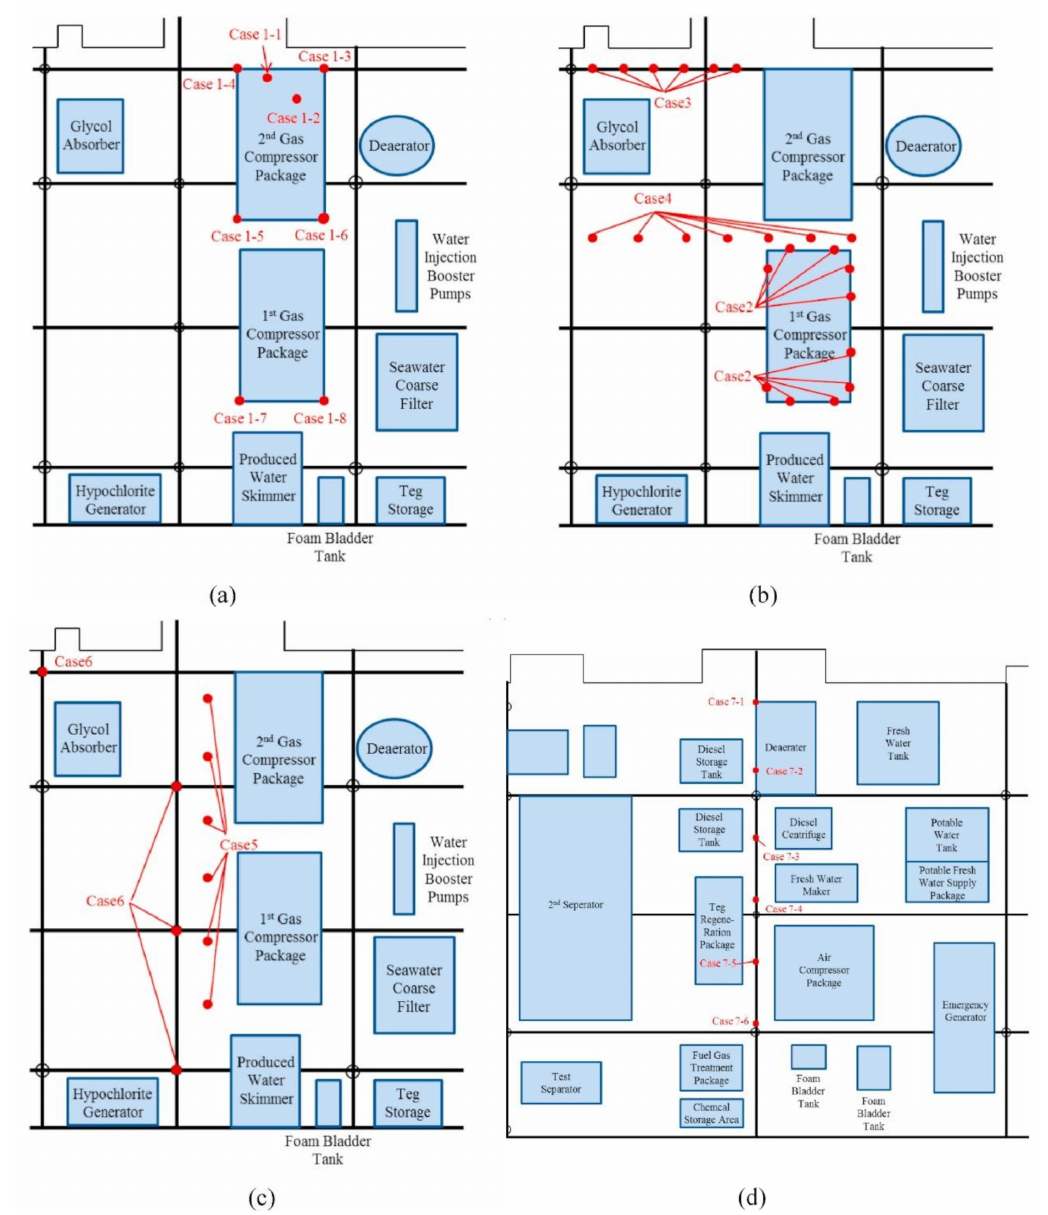
Figure 21. The layout and the in situ measurement points: ( a ) case 1; ( b ) cases 2–4; ( c ) cases 5 and 6; ( d ) case 7